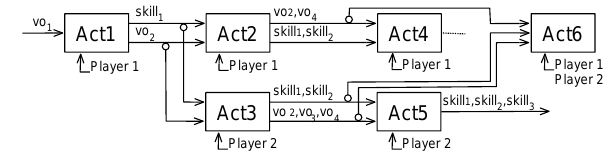
Figure 1. Scenario of a learning